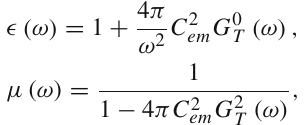
from left to right correspond to increasing Born–Infeld parameter, i.e., b = 0 . 00 (red), 0 . 05 (blue), 0 . 10 (green) and 0 . 15 (black), respectively. For concreteness, we have set the mass of the scalar field m 2 = −